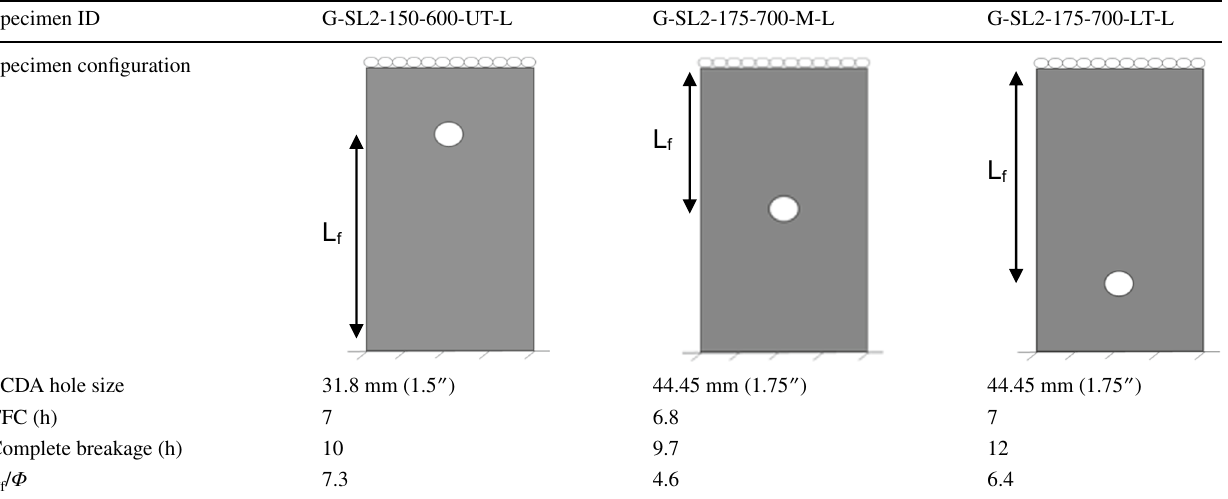
Table 3 Summary of L